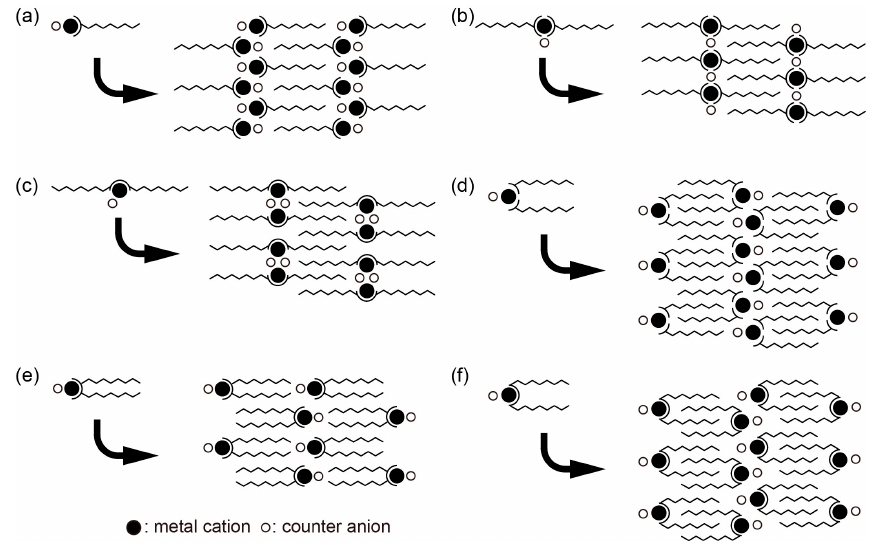
Figure 4. Extracted coordination and packing modes observed in hybrid surfactant single crystals composed from discrete metal cations and surfactant ligands: ( a ) asymmetric coordination of one single-chained ligand; ( b ) symmetric coordination of two single-chained ligands; ( c ) symmetric coordination of one double-chained ligand; ( d ) asymmetric coordination of two single-chained ligands; ( e ) asymmetric coordination of one double-chained ligand with narrow space between the chains; ( f ) asymmetric coordination of one double-chained ligand with wide space between the chains. Here “symmetric” means that amphiphilic chains lie in the opposite sides of metal cation, and “asymmetric” means that amphiphilic chains lie on the same side of the metal cation.